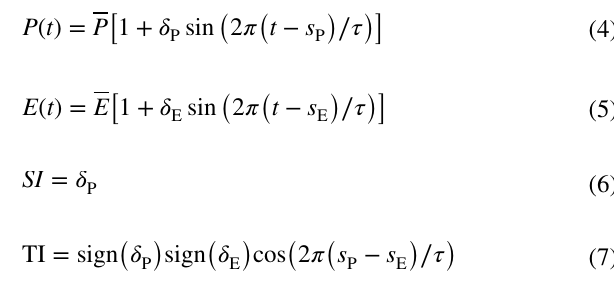
Table 1 Overview of the hydrological signatures selected in this study